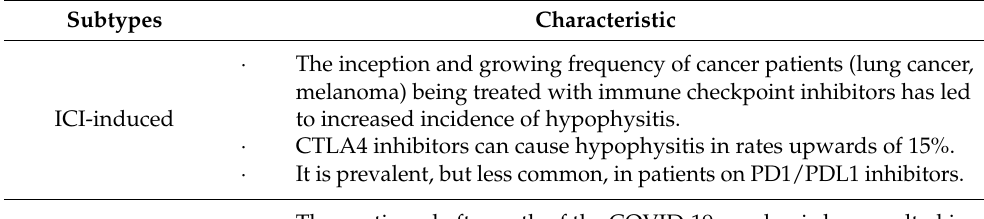
Table 2. Secondary autoimmune and emerging, novel clinical causes of